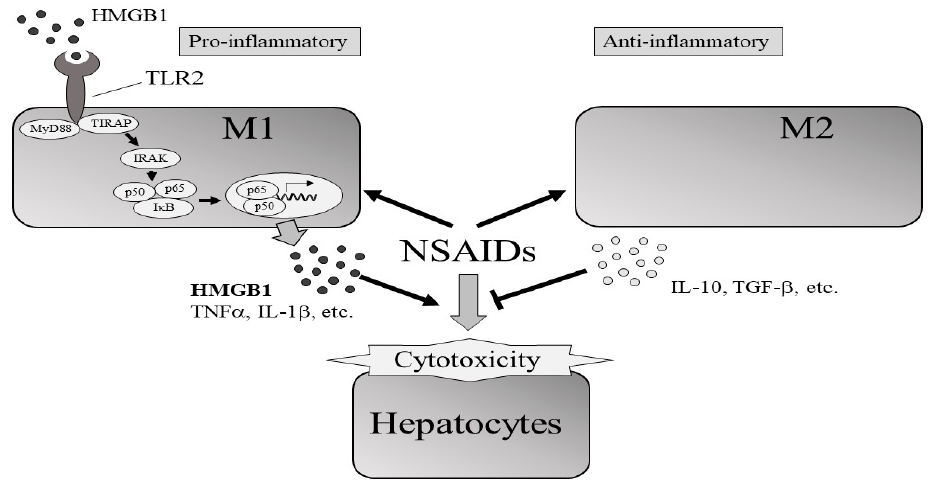
Figure 7. Effects of the presence of M1 or M2 macrophages on NSAIDs-induced cytotoxicity of hepatocytes. The protective effects of M2 on cytotoxicity could be partially explained by decreased signaling through the HMGB1/TLR2 axis in M2 compared with in to